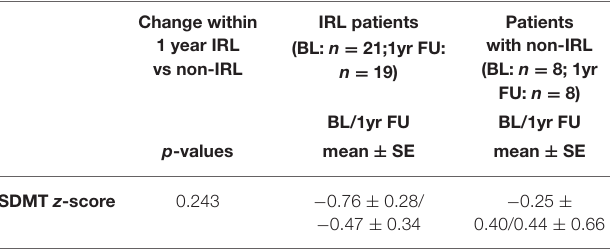
TABLE 3 | Change of SDMT z -scores within 1 year between IRL and non-IRL patients of the total cohort. IRL Change within 1 year IRL vs non-IRL